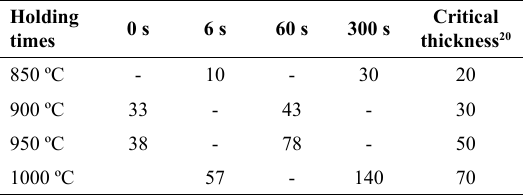
Table 2. Predefined holding times and thickness of oxide scales before rolling process (µm) Holding